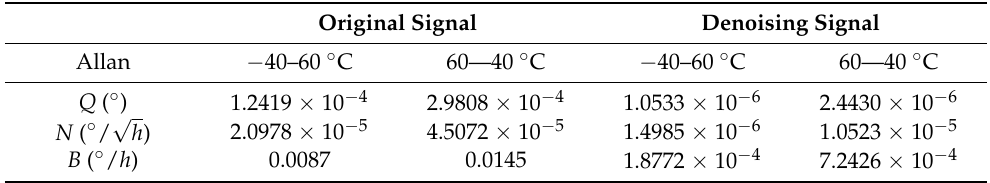
Table 2. The Allan variance of the compared experiment based on original signal and the improved